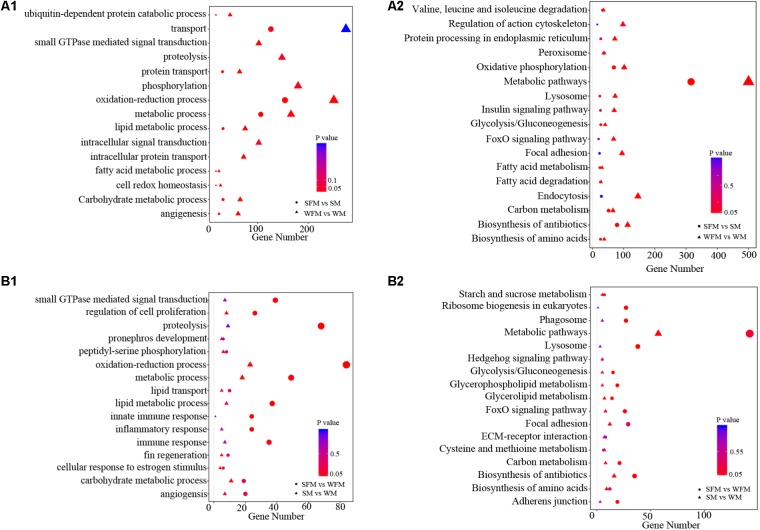
The GO terms enrichment (A1,B1) and KEGG pathway (A2,B2) analyses of DEGs among different comparisons. The X-axis (gene number) indicates the number of DEGs in each GO functions and KEGG pathway. The color and size of dot represent P-value and number of DEGs assigned to the corresponding GO term and KEGG pathway, respectively.